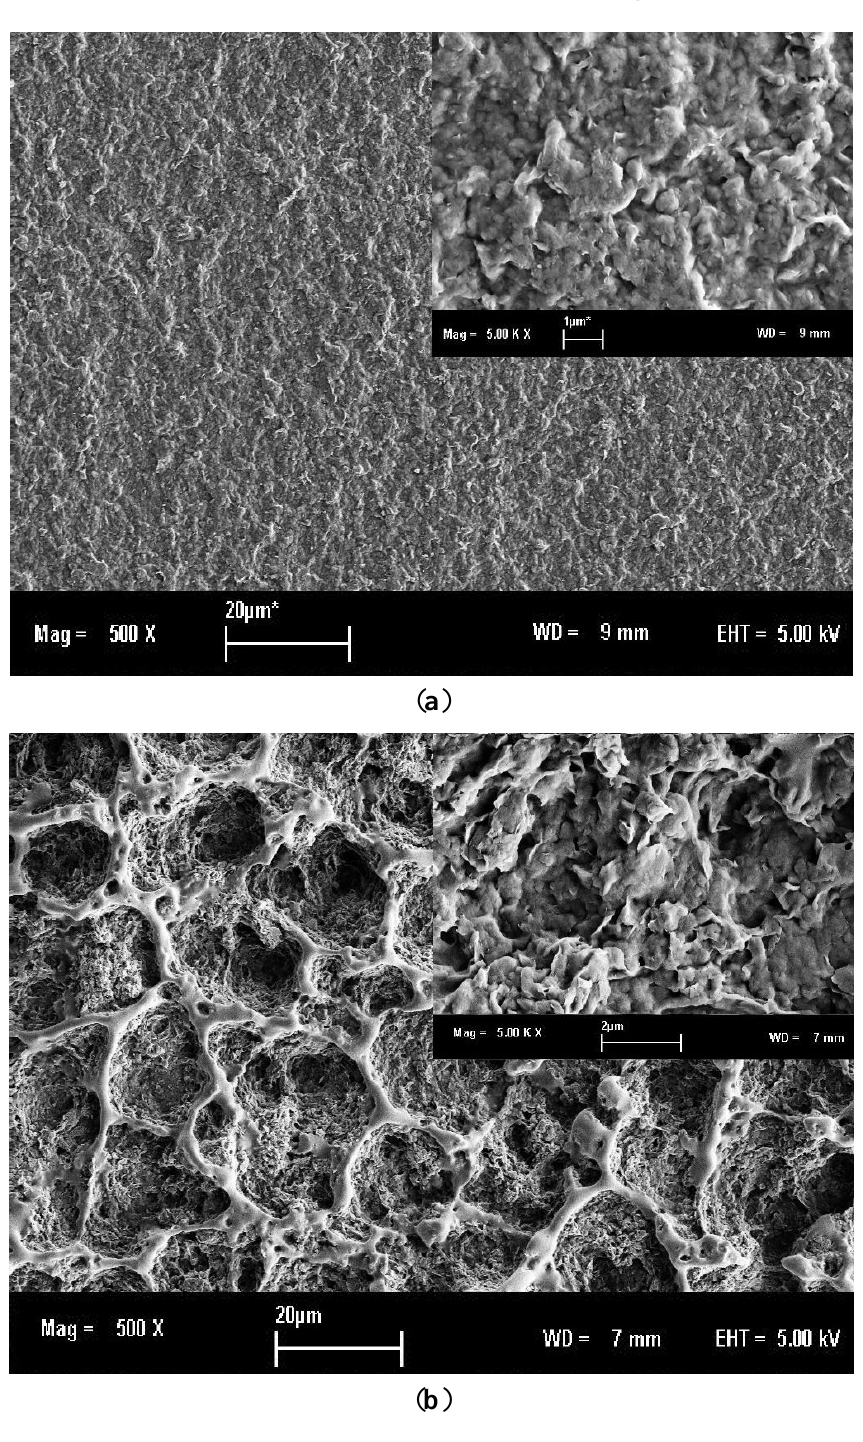
Figure 2. SEM micrographs of equal fraction of PHB/ENR-50 blend containing ( a ) 3 and ( b ) 5 wt% MMT (both at 5 kV with 500× and inset: 5000×